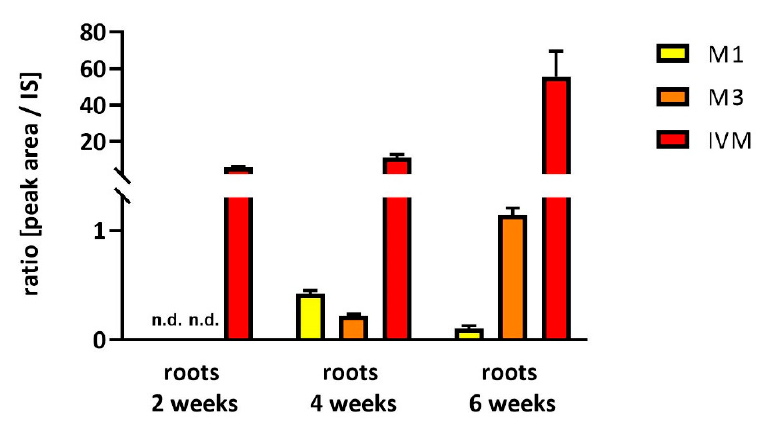
Figure 1. Relative amount of IVM and its main metabolites (M1, M3) in the roots and leaves of soybean plants after 42 days of treatment. Data are expressed as mean ± SD ( n = 6), n.d. = not detected.